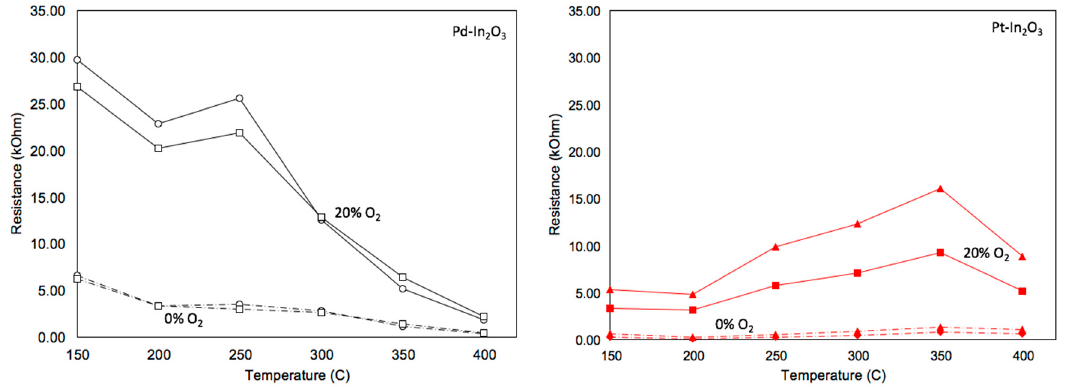
Figure 3. Average resistance values of Pd-In 2 O 3 ( left ) and Pt-In 2 O 3 ( right